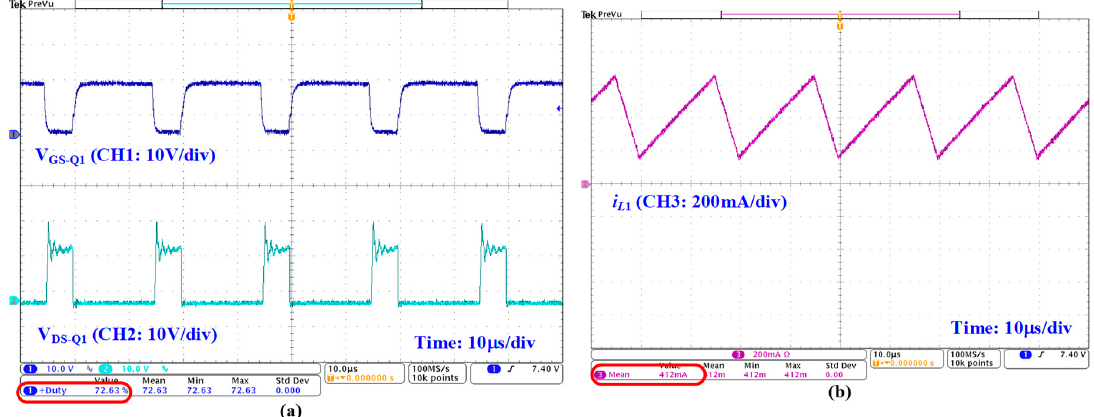
Figure 12. Measured waveforms of PCL 1 with the FDC method: ( a ) switch voltages of V GS-Q1 and V DS-Q1 , ( b ) inductor current of i L 1 .